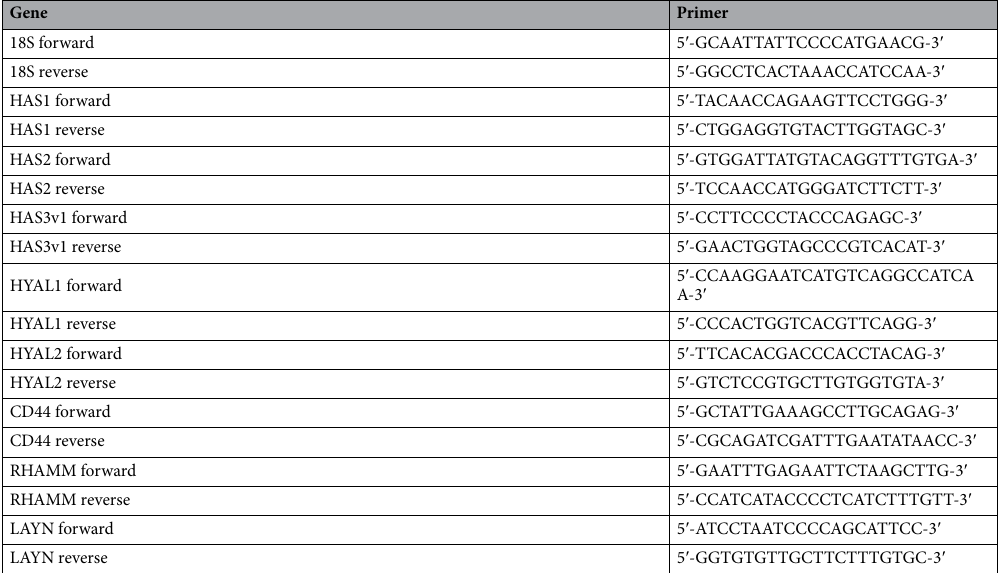
Figure 7. Intimate interaction between invasive breast cancer cells and mesenchymal stem cells is mediated by the hyaluronan system via layilin. To investigate the role of the hyaluronan system in the interaction between cancer cells and bmMSCs either the HA synthesis of the bmMSCs was inhibited with 4-MU (100 µM) or by silencing the expression of the HA interacting receptors in the cancer cell lines MDA-MB-231 and U87-MG via siRNA. ( a ) Representative cytochemical stainings of a direct co-culture of bmMSCs and CFSE-labelled MDA-MB-231 and U87-MG cells (green). BmMSCs were previously treated with 4-MU (100 µM) over a period of 72 h. Cells were stained 48 h after the co-cultures were established. Scale bar = 50 µm. ( b ) Percentage of MDA-MB-231 and U87-MG cells co-localising with bmMSCs after bmMSCs were treated with 4-MU (100 µM). ( c ) The accumulated distance and ( d ) the time spent in juxtaposition of bmMSCs as quantified by time-lapse microscopy. ( e ) Representative cytochemical stainings of a direct co-culture of bmMSCs and HA receptor- depleted cancer cells. The expression of the HA interacting receptors in MDA-MB-231 and U87-MG cells was silenced via siRNAs directed against CD44, RHAMM and LAYN. Afterwards, the cancer cells were stained with CFSE (green). Scale bar = 200 µm, inset = 50 µm. ( f ) Analysis of the percentage of MDA-MB-231 and U87-MG cells co-localising with bmMSCs. Time-lapse quantification of ( g ) accumulated distance and ( h ) time spent in juxtaposition of HA receptor depleted cancer cells. n = 4. Mean ± SEM. * p < 0.05 compared to the respective control treated cells. This figure was prepared with GraphPad Prism (v9.2.0.332, www. graph pad.